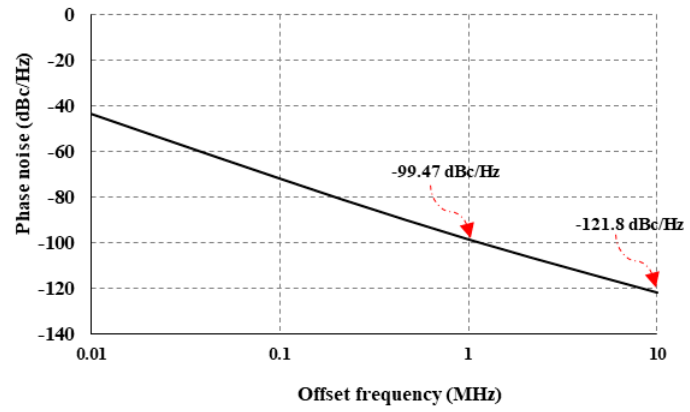
Figure 8. Simulated VCO tuning range ( a ) output of the VCO; ( b ) output of the triple.